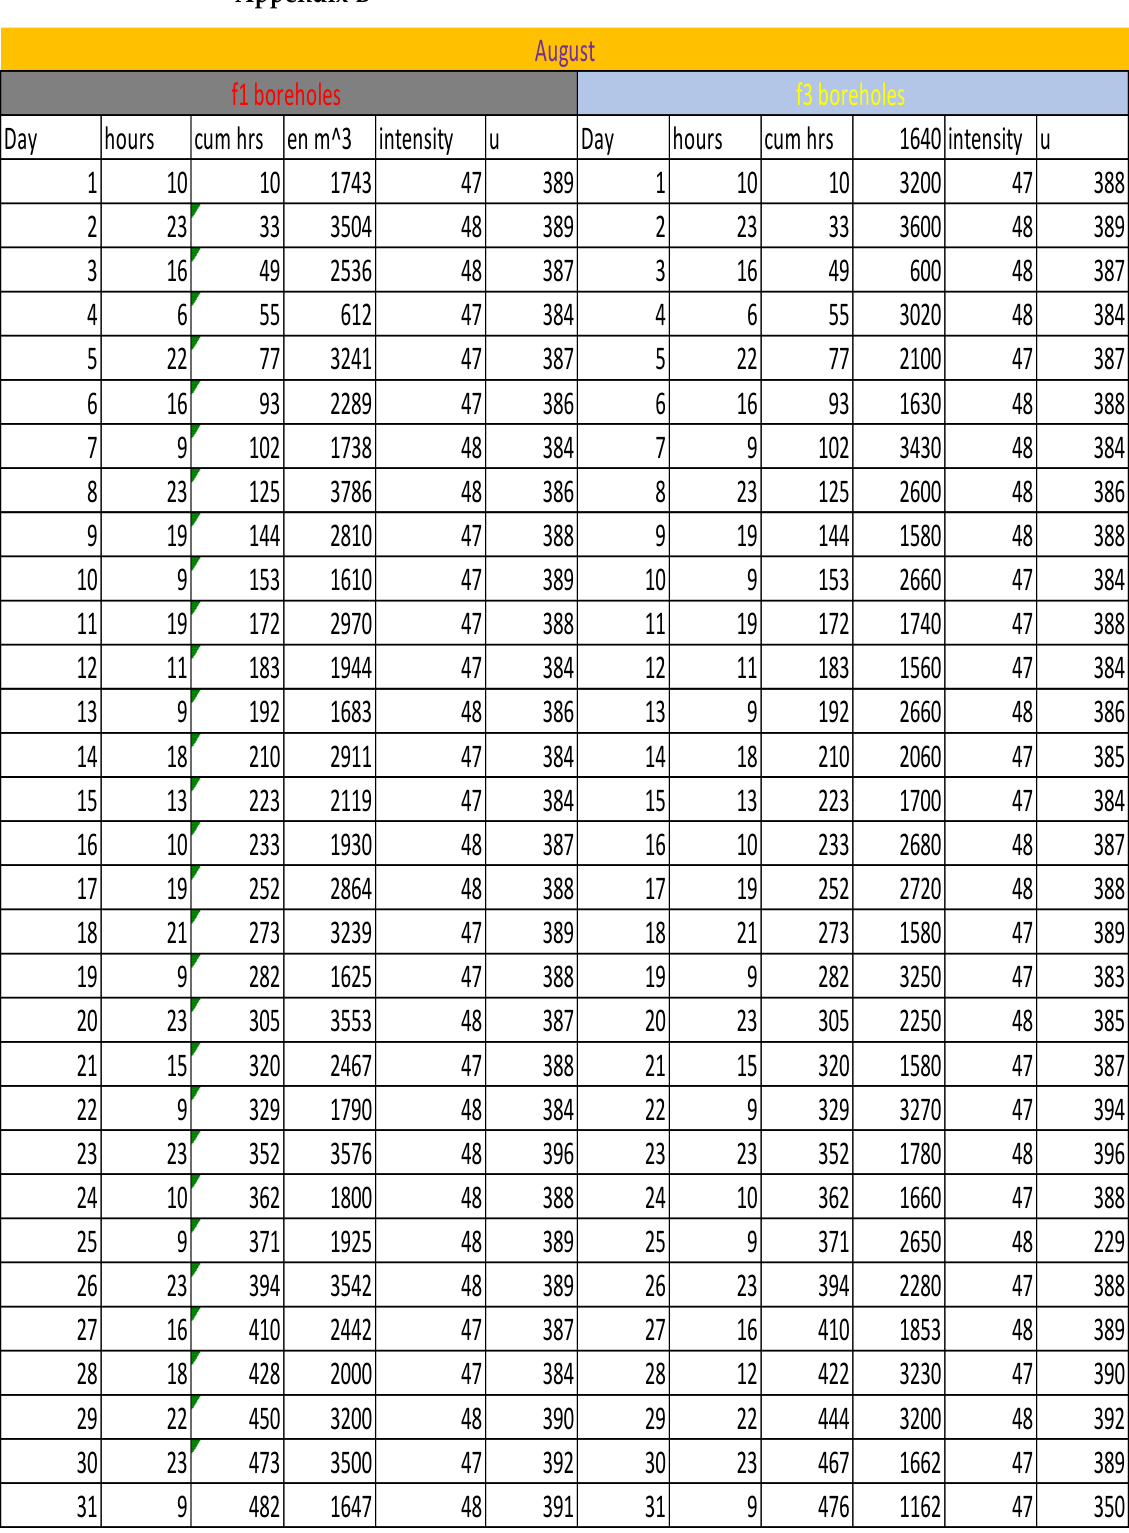
Figure A2. Daily yield on Kimbanseke for August.